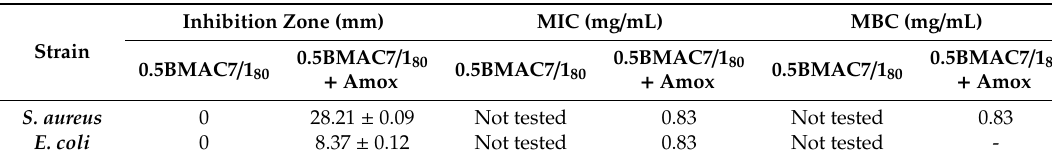
Table 3. Antimicrobial activities of the sample 0.5MAC7 / 80 unloaded and loaded with Amox against S.aureus and E.coli . MBC:minimumbactericidalconcentration; MIC:minimuminhibitoryconcentration.